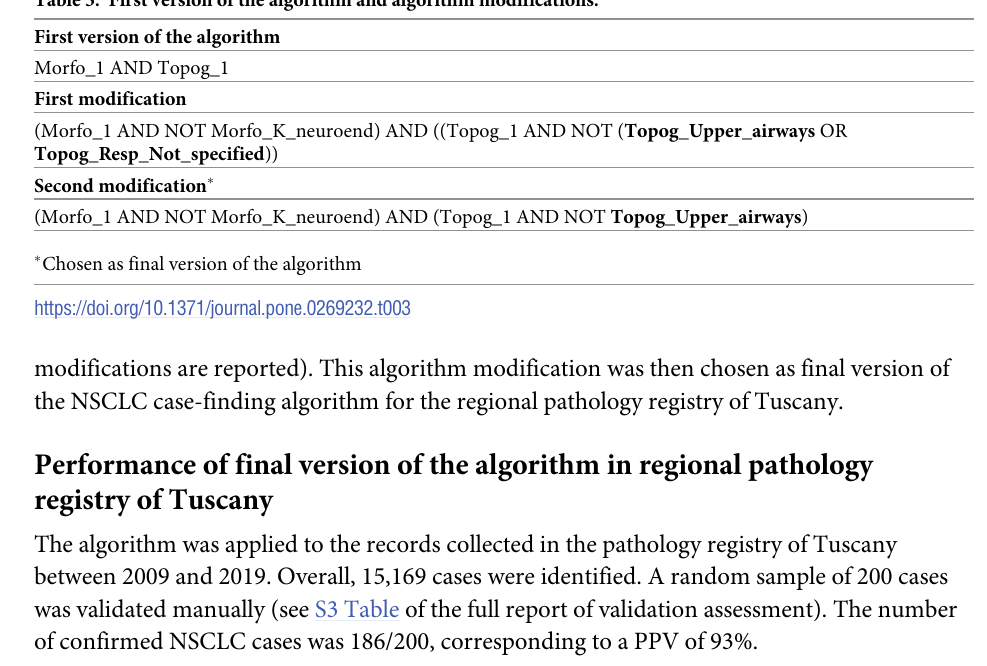
PLOS ONE | https://doi.org/10.1371/journal.pone.0269232 June 8,